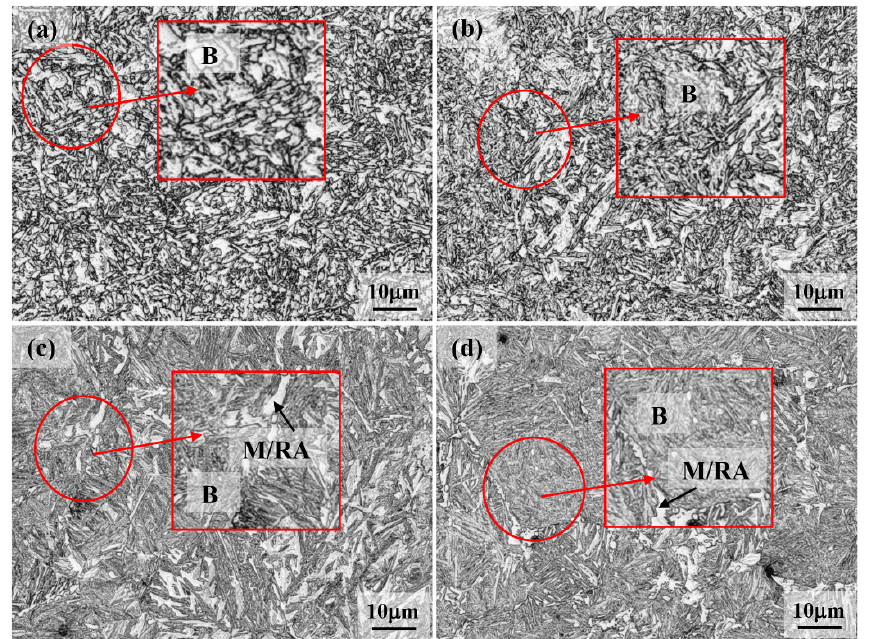
Figure 8. Micrographs recorded on Q&B samples quenched at ( a ) 450 °C, ( b ) 400 °C, ( c ) 350 °C and ( d ) 300 °C temperatures and held for 1 h isothermal holding. B and M/RA represent bainite and martensite–retained austenite islands, respectively.